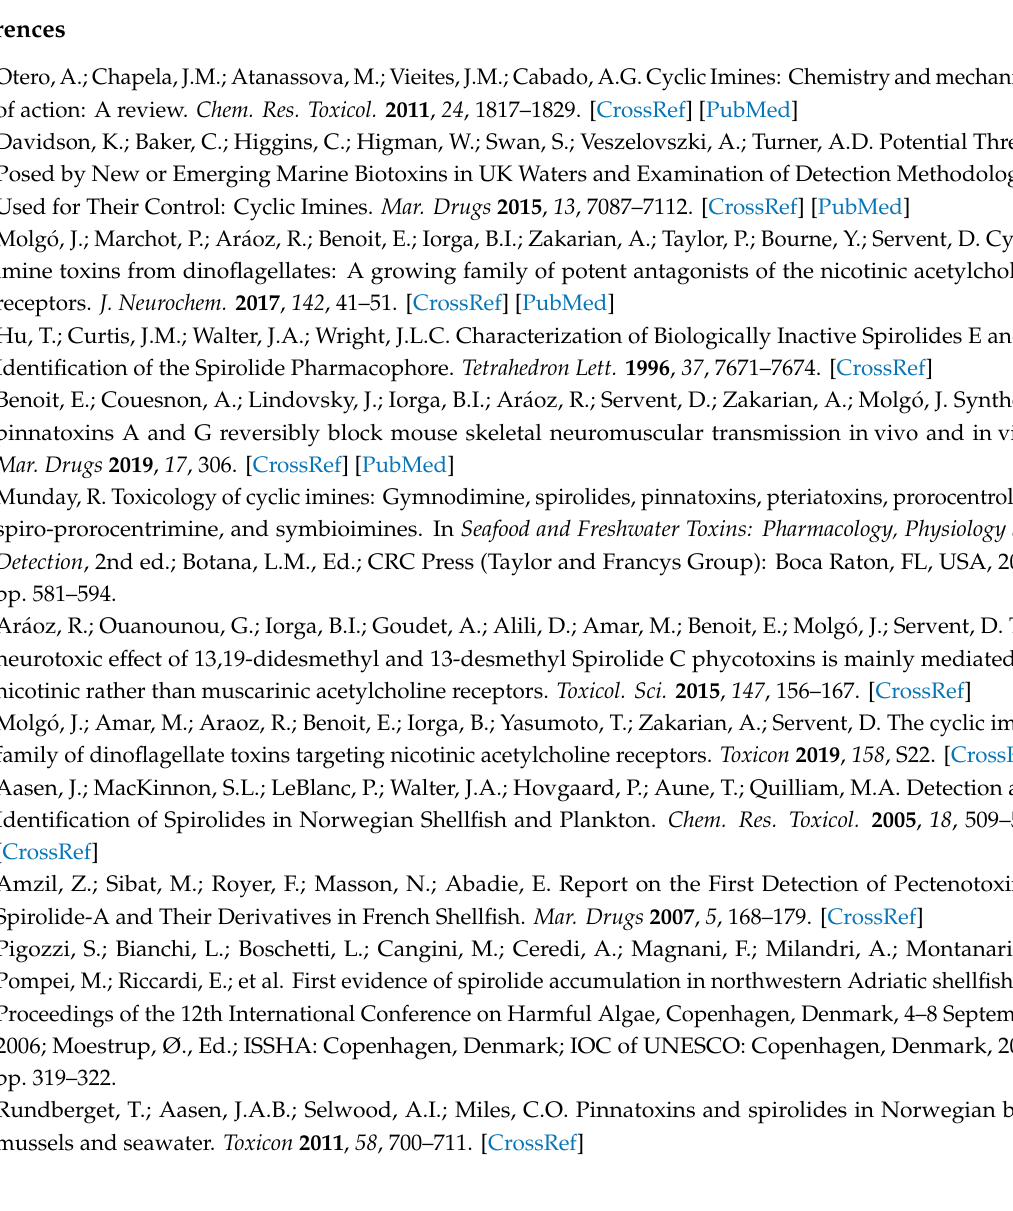
Figure S1: Representative dynamic multiple reaction monitoring (DMRM) chromatogram of CIs; Figure S2: Overlapped total ion chromatogram (TIC) of sample RA3.4 before and after SPE; Figure S3: Structure of PnTX-A and fragment ions selected for multiple reaction monitoring (MRM) analysis; Figure S4: Multiple reaction monitoring (MRM) chromatograms for PnTX-A acquired on sample RA3.4 after